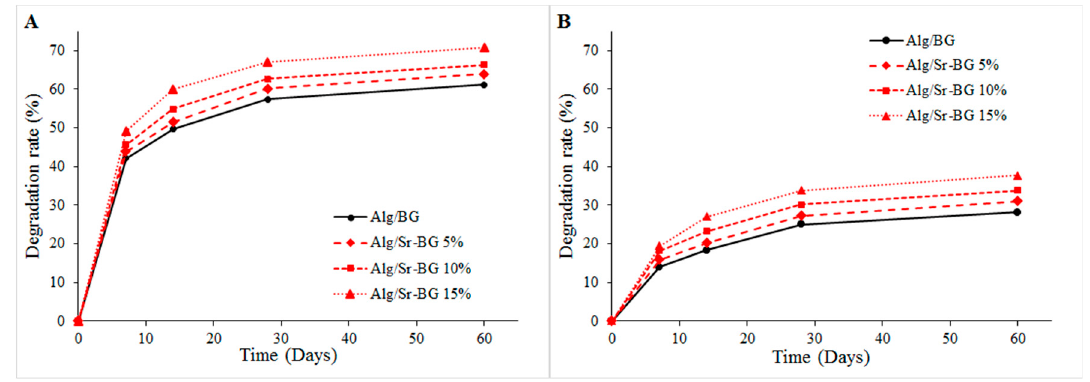
Figure 7. Biodegradation profile of four kinds of alginate scaffolds as a function of immersion time in ( A ) AcOH buffer and ( B ) PBS over 60 days.